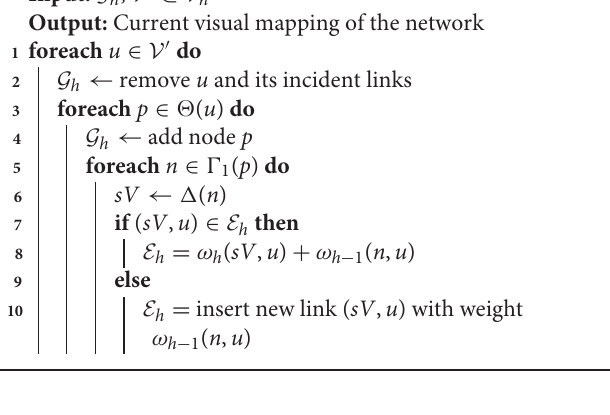
Algorithm 1: BiNetVis algorithm for multilevel visualization of a bipartite network.